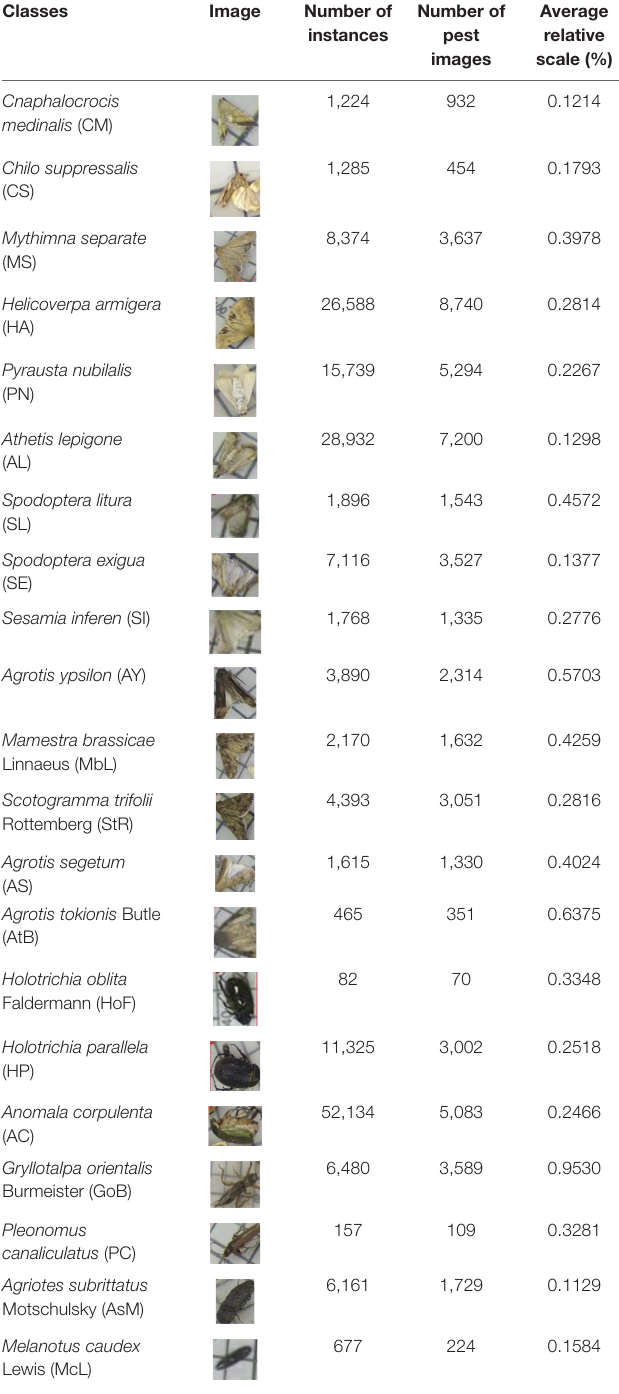
TABLE 1 | Details of 21 types of agricultural pest, including the pest images, number of pest instances of each category, number of pest images of each category, and the average relative scale of each pest